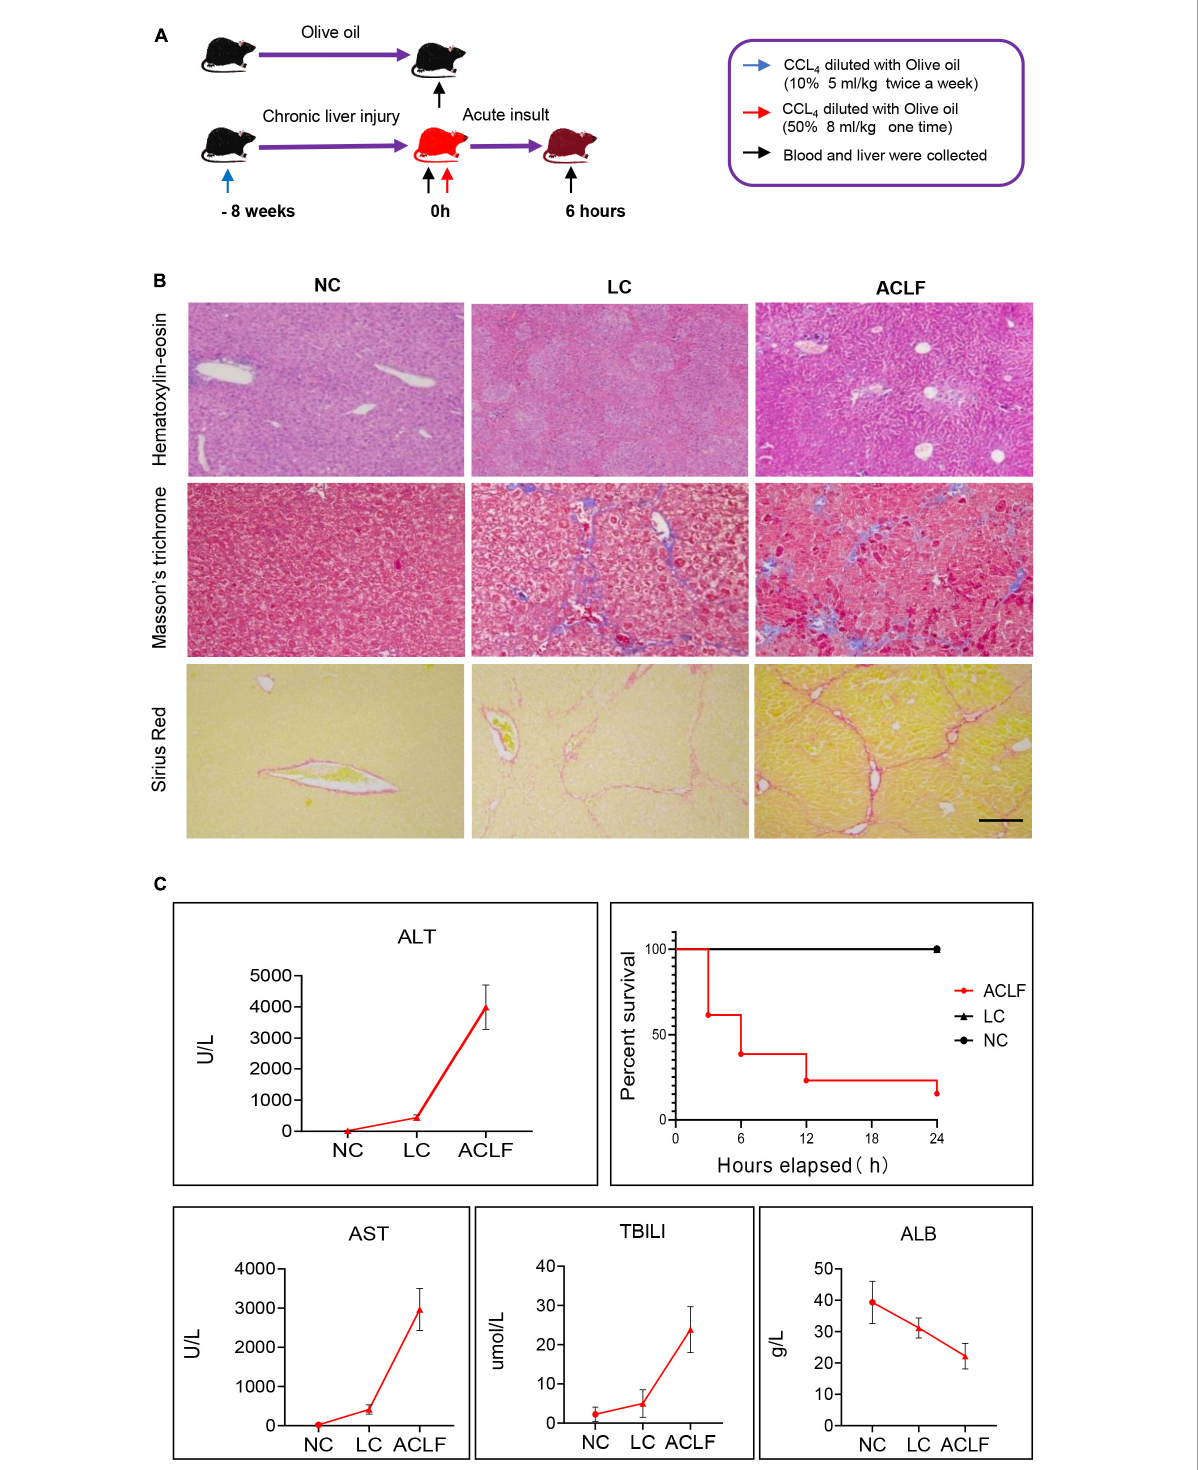
FIGURE6 Establishment of the acute-on-chronic liver failure mouse model. (A) Schematic diagram of the mouse ACLF model. (B) Pathological staining (H&E, M&T and S&R) of liver tissues at different disease stages (bar = 100 µ m). (C) Four typical biochemical markers of liver function were evaluated in the three groups ( n = 6/6/6, NC/CHB/ACLF groups), and mortality was observed in the ACLF group. ACLF, acute-on-chronic liver failure; LC, liver cirrhosis; NC, normal control; H&E, hematoxylin-eosin; M&T, Masson’s trichrome; S&R, Sirius red; ALT, alanine aminotransferase; AST, aspartate aminotransferase; TBILI, total bilirubin; ALB,